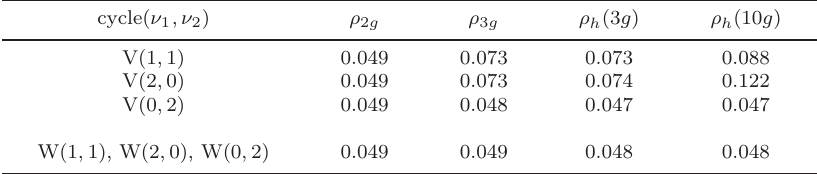
Table 1. LFA two–grid, ρ 2 g , and three-grid, ρ 3 g , convergence factors, and experimen- tally measured asymptotic convergence rates obtained with a zebra-type smoother for an isosceles triangle of common angle 80 o .